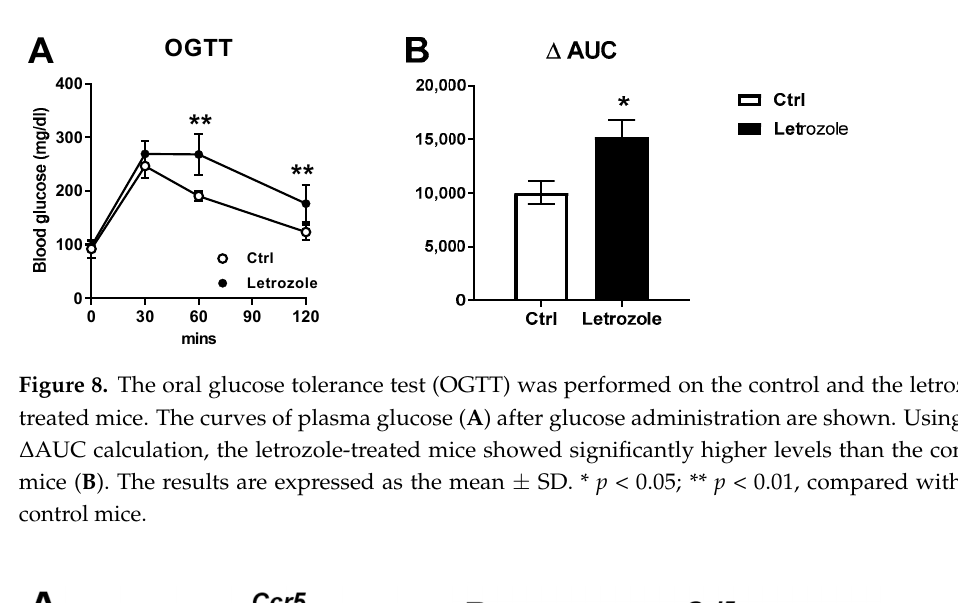
Figure 8. The oral glucose tolerance test (OGTT) was performed on the control and the letrozole- treated mice. The curves of plasma glucose ( A ) after glucose administration are shown. Using the ∆ AUC calculation, the letrozole-treated mice showed significantly higher levels than the control mice ( B ). The results are expressed as the mean ± SD. * p < 0.05; ** p < 0.01, compared with the control mice.